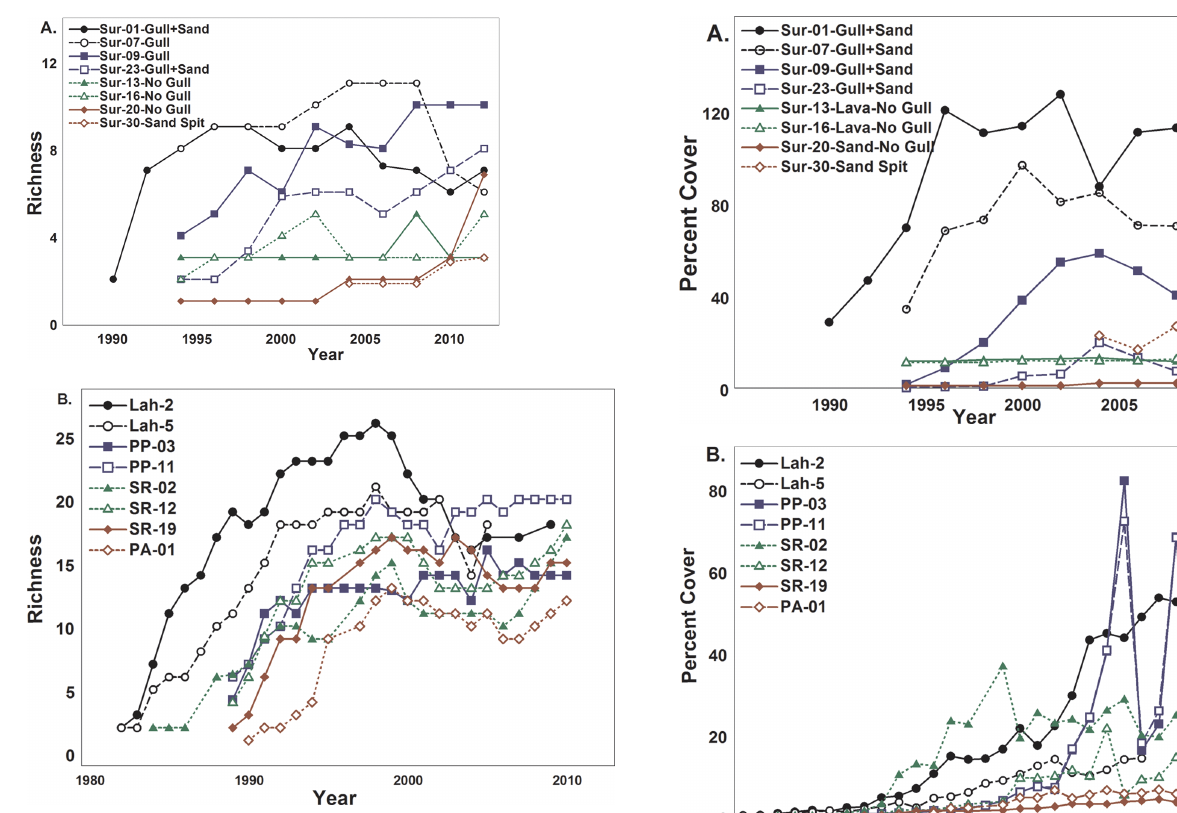
Fig. 12. Richness development on selected plots: (A) Surtsey; (B) Mount St. Helens.